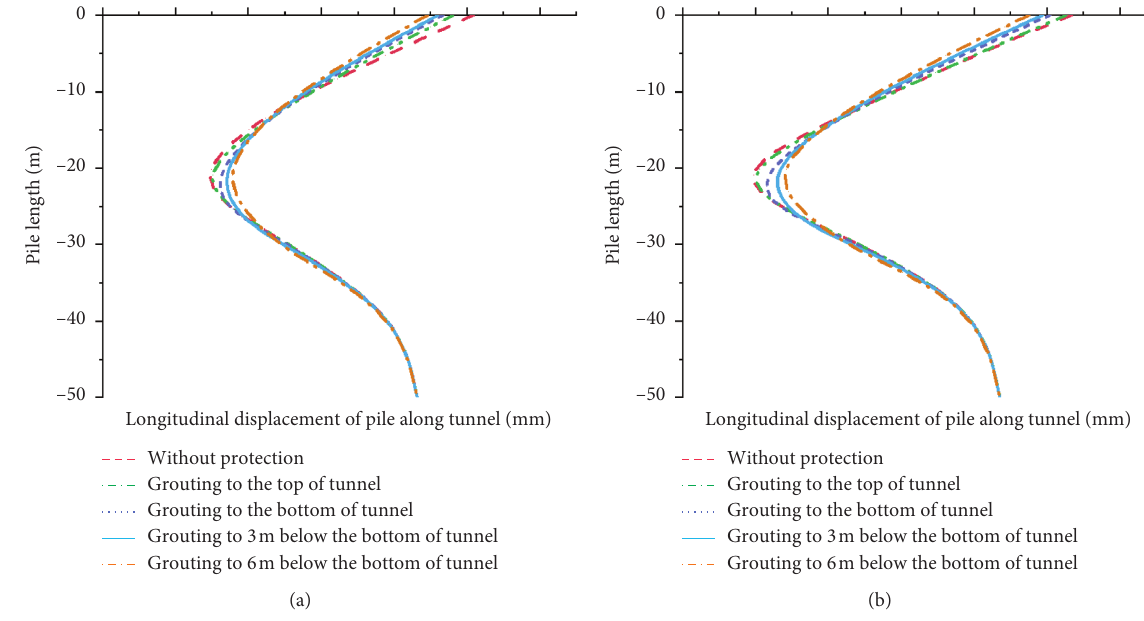
Figure 15: Longitudinal displacement of the pile along the tunnel: (a) 6 rings before arriving at the pile; (b) 4 rings before arriving at the